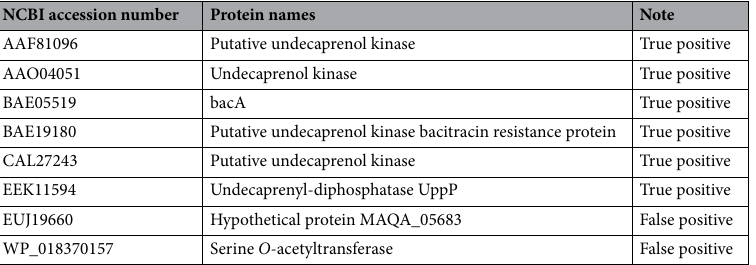
Table 1. Predicted bac AMR sequences for Staphylococcus , Streptococcus , and Listeria using the GTDWFE